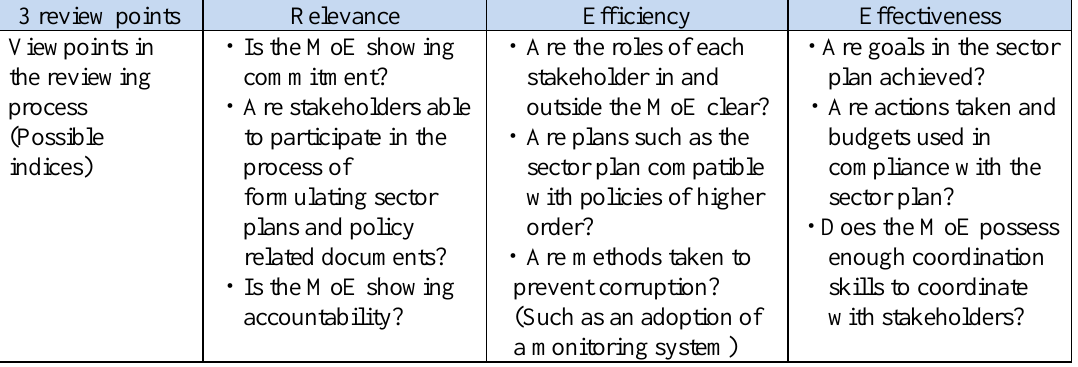
Table 5-2: Frame to Review the Management Capacity of the Ministry of